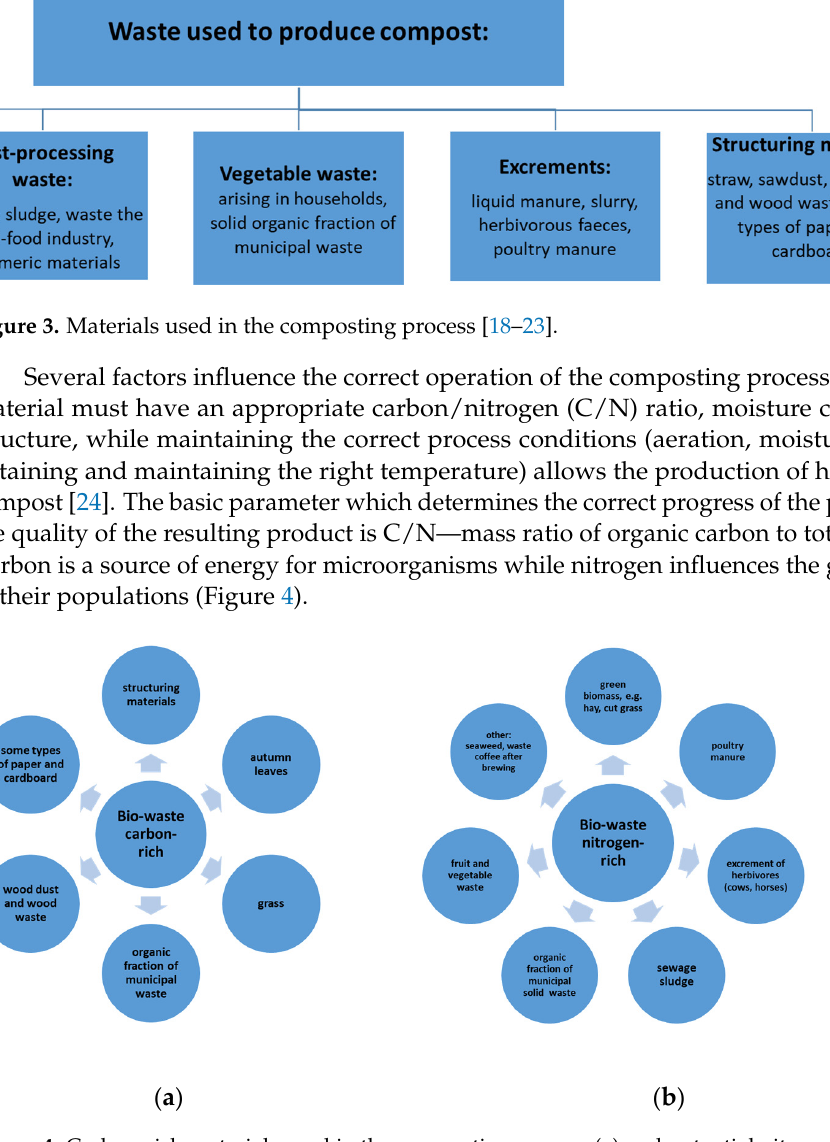
Figure 4. Carbon-rich materials used in the composting process ( a ) and potential nitrogen sources for compost mixes ( b ) [25–29].